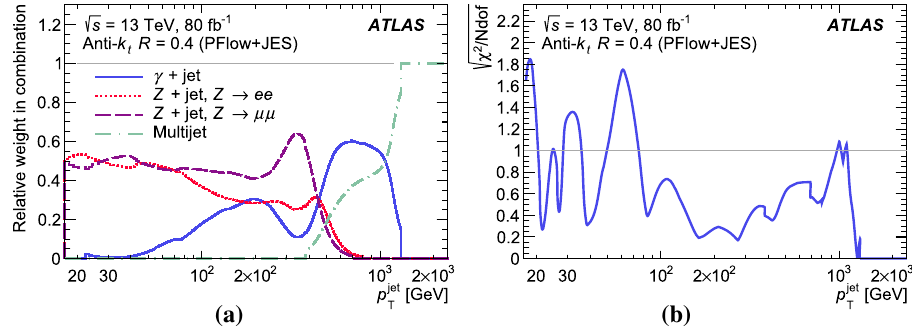
Fig. 19 a The weight assigned to different techniques in the combi- nation of in situ measurements of the relative p T response of anti- k t R = 0 . 4 particle-flow jets in data and simulation, as a function of the jet p T . For each p T bin, the weights of the Z +jet, γ +jet, and multi- jet balance methods are shown. b The χ 2 / N dof metric, illustrating the